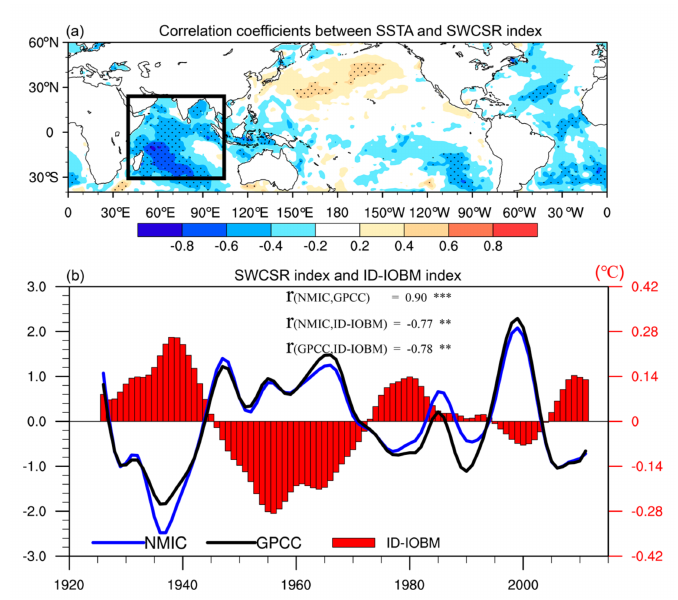
Figure 3. ( a ) Correlation coefficients between sea surface temperature anomalies and the SWCSR index. Black dots indicate areas significant at the 95% confidence level. The rectangle denotes the studied region for Indian Ocean; ( b ) the SWCSR index (lines) and the interdecadal Indian Ocean basin mode (ID-IOBM) index (red bars). Blue (black) line denotes the SWCSR index derived from the National Meteorological Information Center (NMIC) (GPCC) data. ** and *** indicate correlation coefficients significant at the 95% and 99% confidence level,